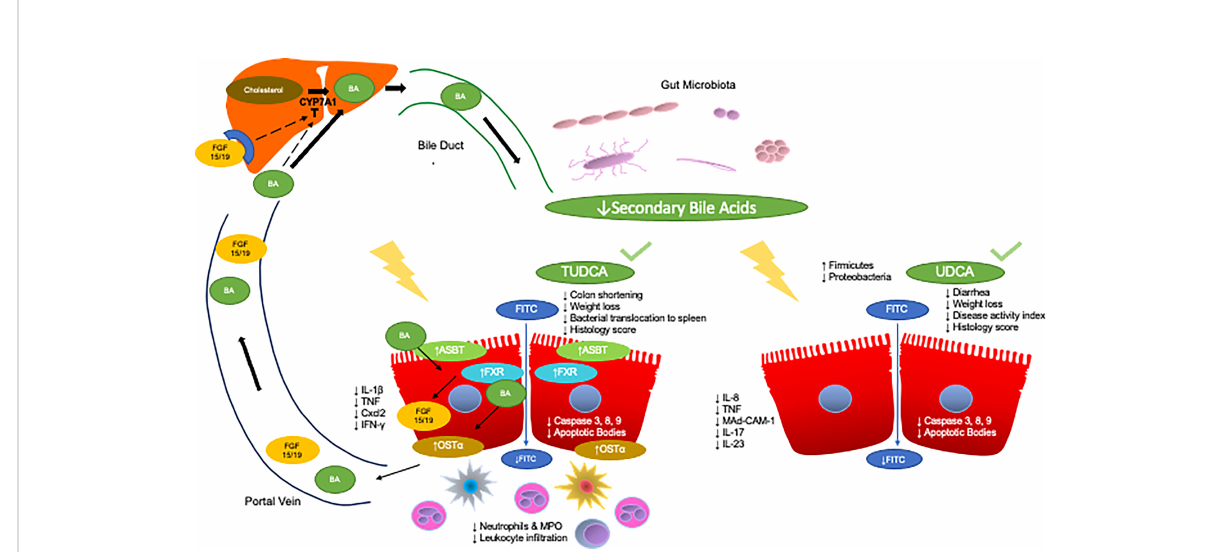
FIGURE 1 Anti-in fl ammatory effects of TUDCA and UDCA in models of IBD. The enterohepatic circulation of bile acids transports bile acids synthesized and modi fi ed in the liver to the intestines through the bile duct. The rate limiting step of hepatic synthesis of bile acids is mediated by the CYP7A1 enzyme which is inhibited by bile acids and ileal FGF15/19. Gut microbes then convert primary bile acids into secondary bile acids. Gut microbial dysbiosis in IBD leads to a reduction in the secondary bile acid pool. Speci fi cally, two key secondary bile acids have been shown to exert anti-in fl ammatory effects in IBD and relevant models, TUDCA and UDCA. Administration of TUDCA on cell culture and mouse models of IBD aided in bile acid homeostasis by preventing loss of OST a expression as well as increased FXR and ASBT expression. Furthermore, TUDCA protected against colon shortening, weight loss, and led to improvements in histological score. TUDCA also led to the reduction of pro- in fl ammatory cytokines IL-1 b , TNF, Cxcl2, and IFN- g as well as decreased apoptotic signaling. Furthermore, TUDCA led to decrease neutrophilic in fi ltration and activity, as well as general decreases in leukocyte in fi ltration. Administration of UDCA led to less diarrhea and weight loss as well as decreases in disease activity index and histology score. UDCA also led to decreased apoptotic signaling. Furthermore, UDCA led to decreases in IL-8, TNF- a , and Mad-CAM-1 in the colon, and less IL-17 and IL-23 in the serum of subjects with UC as well as increases in the abundance of Firmicutes and decreases in